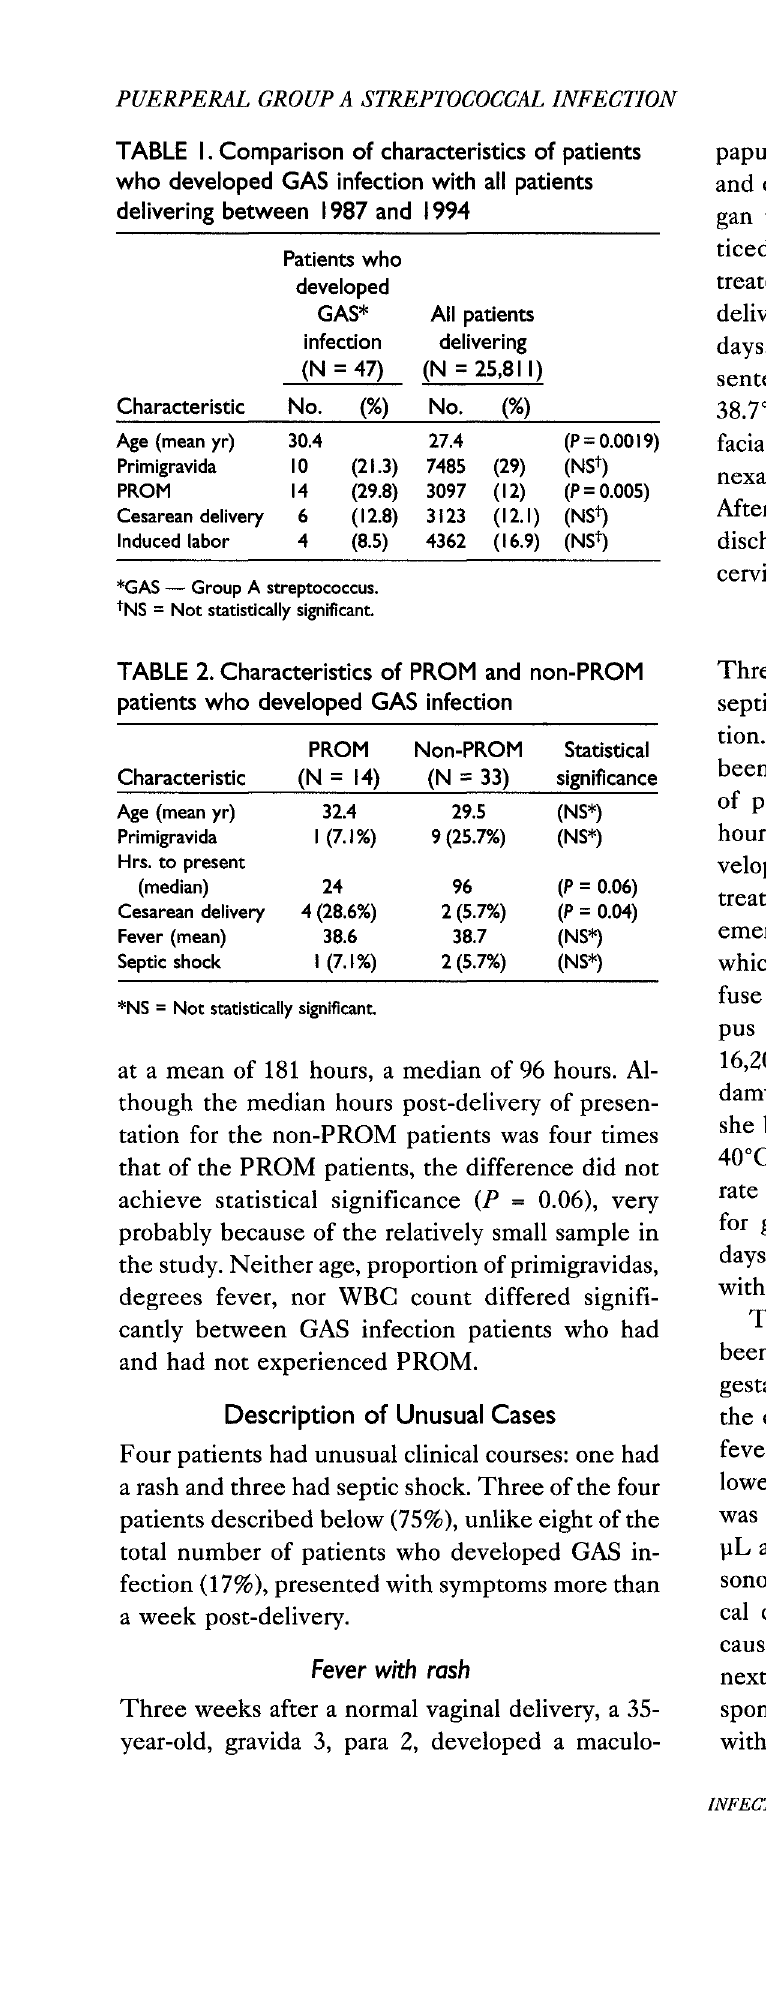
TABLE I. Comparison of characteristics of patients who developed GAS infection with all patients delivering between 1987 and 1994